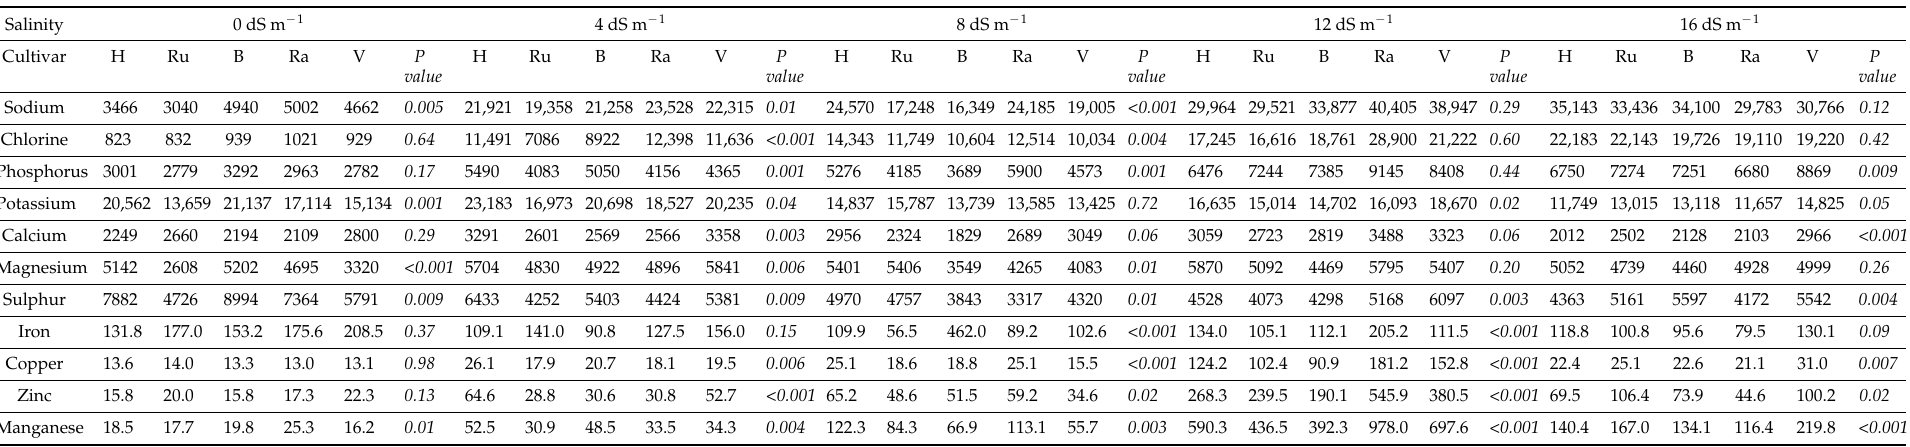
Table 5. Analysis of variance and mean value of elemental concentrations (mg L − 1 ) in root tissue of five alfalfa cultivars (H, ‘Halo’; Ru, ‘Rugged’; B, ‘Bridgeview’; Ra, ‘Rangelander’; V, ‘Vernal‘) under five gradients of salt stresses (Electrical conductivities of 0 dS m − 1 , 4 dS m − 1 , 8 dS m − 1 , 12 dS m − 1 and 16 dS m − 1 ) as revealed by inductively coupled plasma-mass